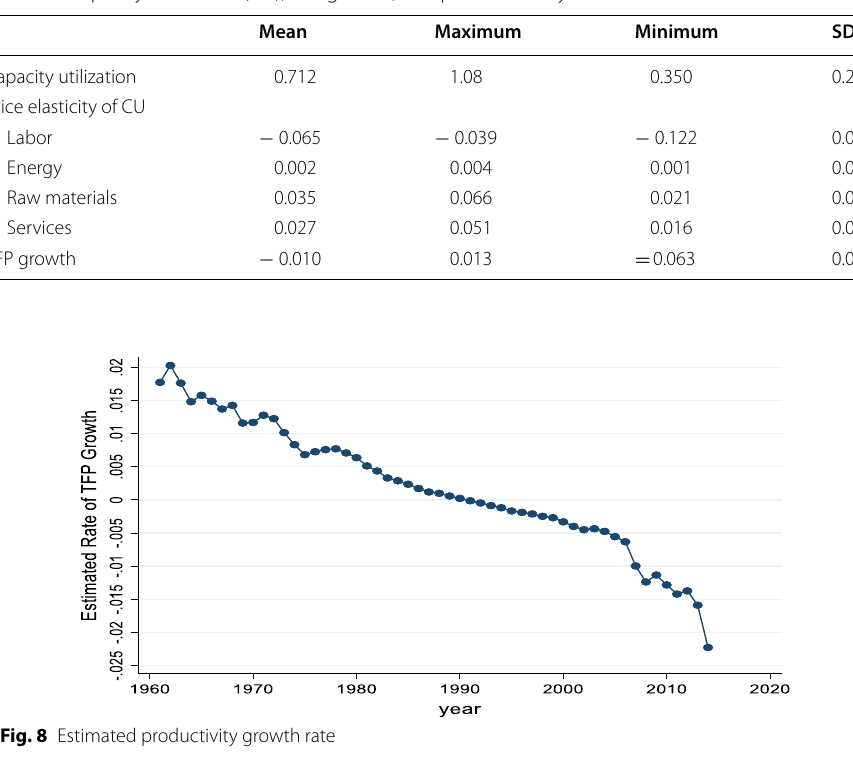
Table 3 Capacity utilization (CU), TFP growth, and price elasticity of CU